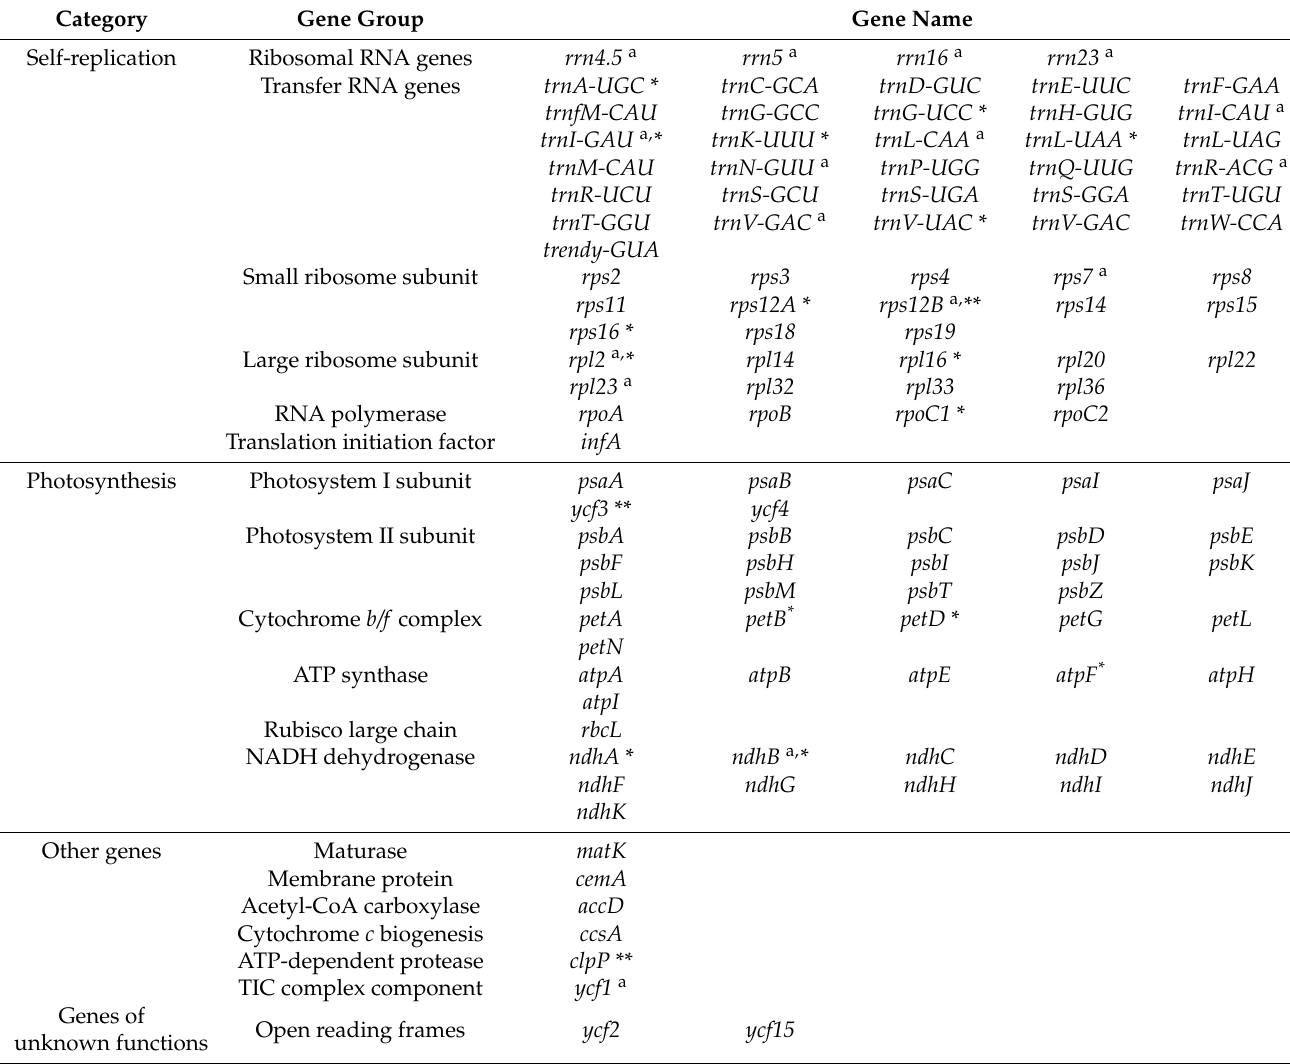
Table 2. Genes in the chloroplast genomes of the four Ilex species. a Genes with two copies; * Genes with one intron; ** Genes with two